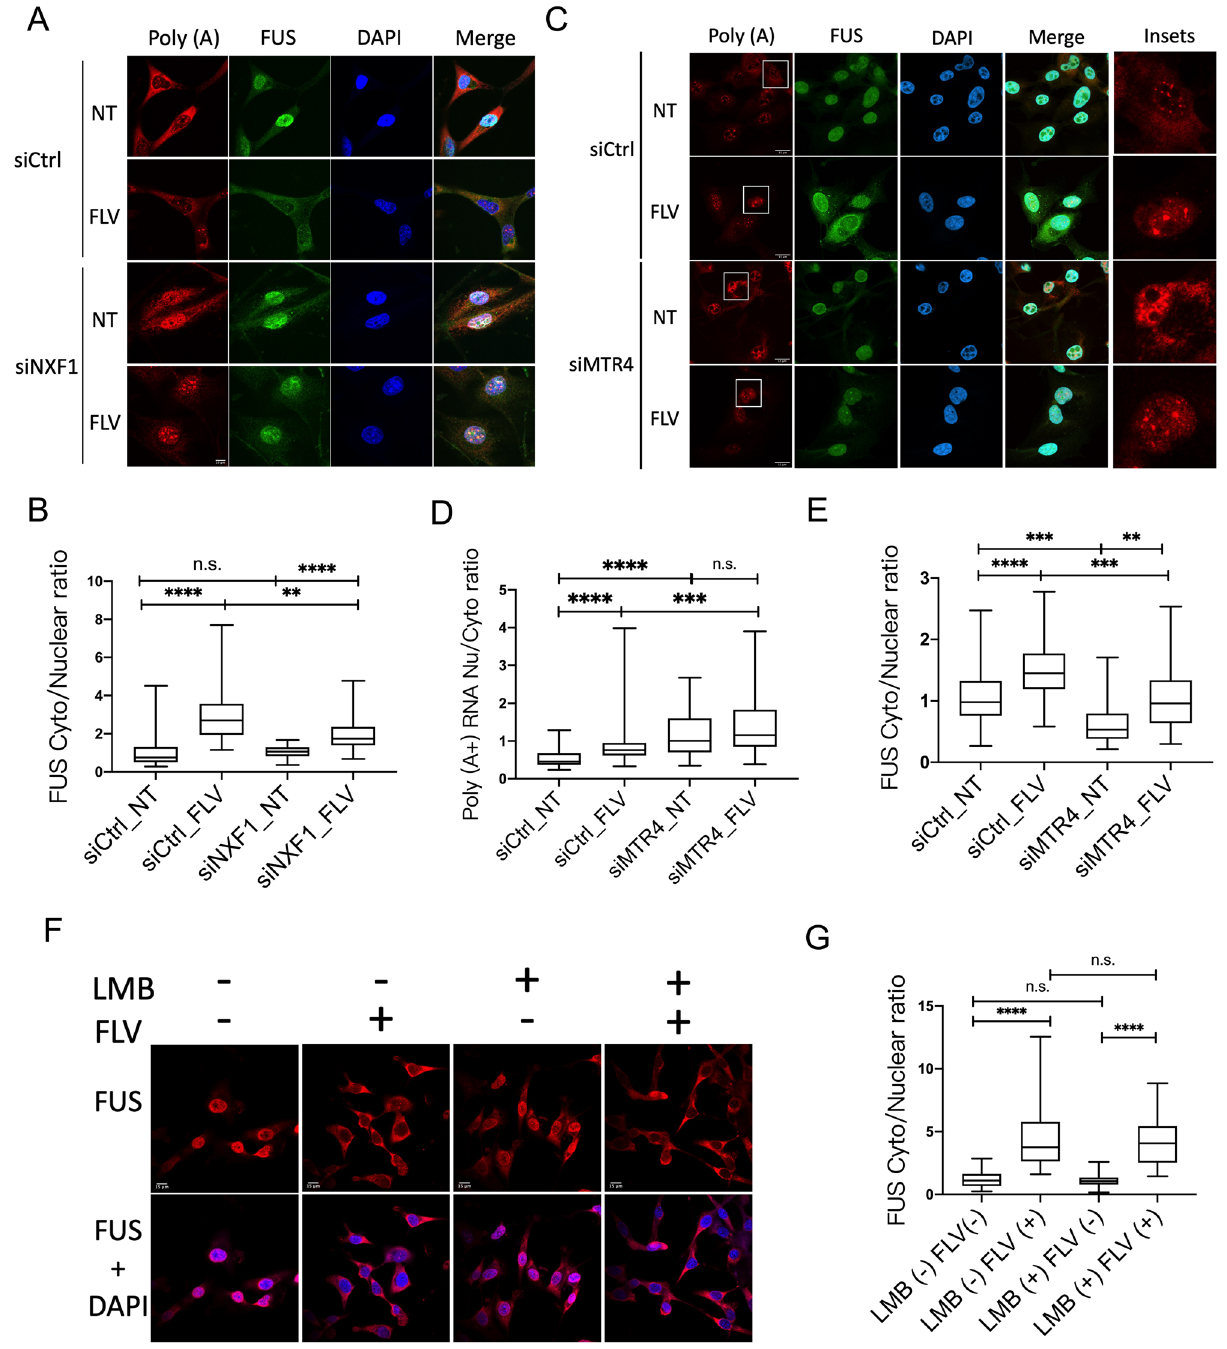
Figure 5. NXF1 and MTR4 knockdown, but not CRM1 inhibition, promotes FUS nuclear retention following transcriptional inhibition. ( A ) U87 cells were transfected with NXF1 siRNA for 48 h followed by poly(A +) RNA FISH and FUS IF. NT: No treatment; FLV: Flavo treatment (1 uM) for 4 h. Scale bar = 10 um. ( B ) Quantification of cytoplasmic to nuclear FUS ratios in siCtrl and siNXF1 transfected cells. n = 19–49 cells were analyzed in each experimental condition. (** p = 0.0033, **** p < 0.0001) Mann–Whitney U -test. ( C ) U87 cells were transfected with MTR4 siRNA for 72 h followed by poly(A +) RNA FISH and FUS IF. NT: No treatment; FLV: Flavo treatment (1 uM) for 4 h. Scale bar = 15 um. (D) Nuclear to cytoplasmic poly(A +) RNA ratios in siCtrl and siMTR4 transfected cells. n = 27–43 cells were analyzed in each experimental condition. (*** p = 0.0007, **** p < 0.0001) Mann–Whitney U -test. (E) Quantification of cytoplasmic to nuclear FUS ratio in siCtrl and siMTR4 transfected cells. n = 27–37 cells were analyzed in each experimental condition. (** p = 0.0015, *** p = 0.0001–0.0004, **** p < 0.0001) Mann–Whitney U -test. (F) U87 cells were treated with flavo (1 µM) and/ or leptomycin B (LMB, 40 nM) for 4 h followed by FUS IF. Scale bars = 15 um. (G) Cytoplasmic to nuclear FUS ratios of flavo- and/or LMB-treated cells. n > 20 cells were analyzed in each experimental condition. (**** p < 0.0001) Mann–Whitney U